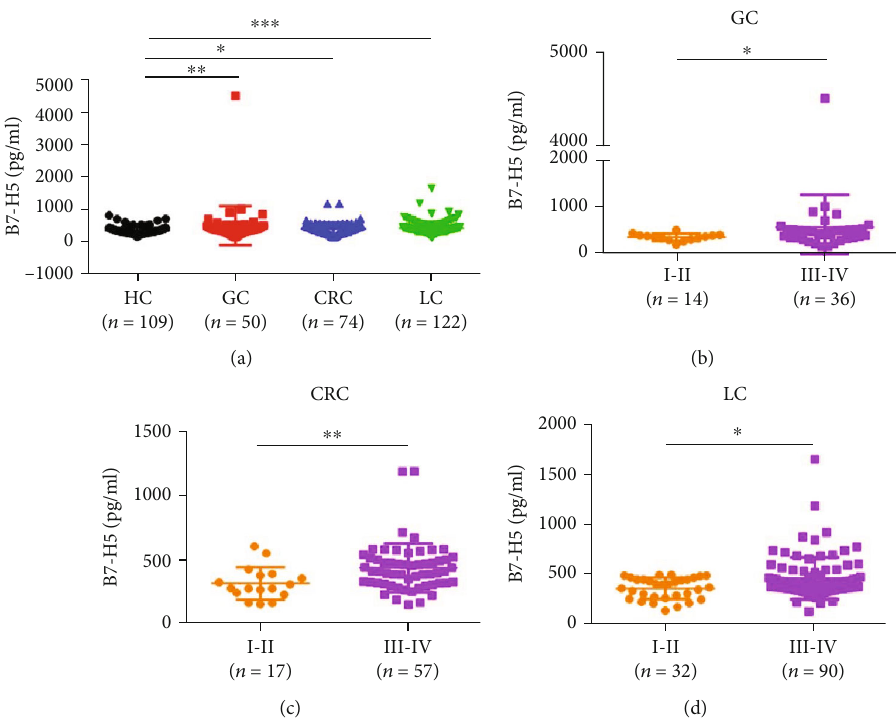
Figure 4: The levels of sB7-H5 in the serum of patients with gastric, colorectal, and lung cancer. (a) The sB7-H5 ELISA showed the concentration of sB7-H5 in the serum of GC ( n = 50 ), CRC ( n = 74 ), and LC ( n = 122 ) patients. (b – d) The association between sB7-H5 levels and TNM stage. ∗ P < 0 : 05 , ∗∗ P < 0 : 01 , and ∗∗∗ P < 0 : 001